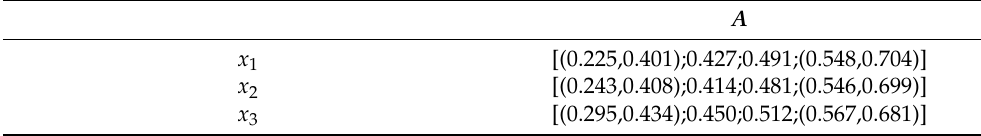
Table A24. Integrated value of surface mine slope risk relative to different risk